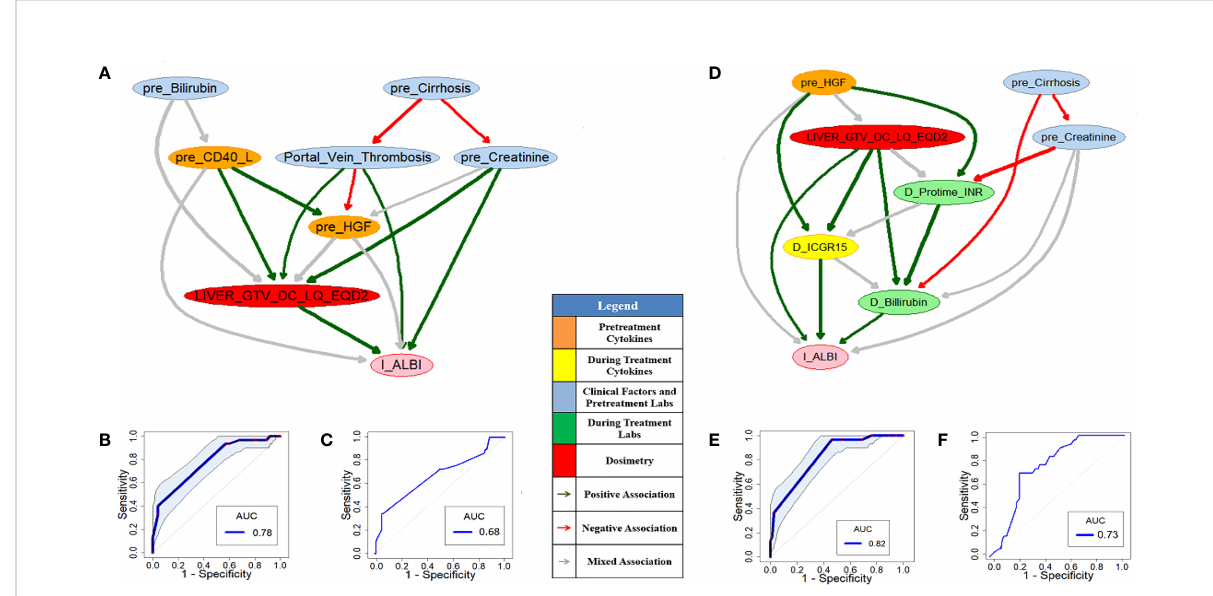
FIGURE 3 Pre- (A) and during-treatment (D) PD-BNs for I-ALBI prediction. The prediction performance of pre- (B) and during-treatment (E) PD-BNs based on the discovery dataset. The prediction performance of pre- (C) and during-treatment (F) PD-BNs based on the testing